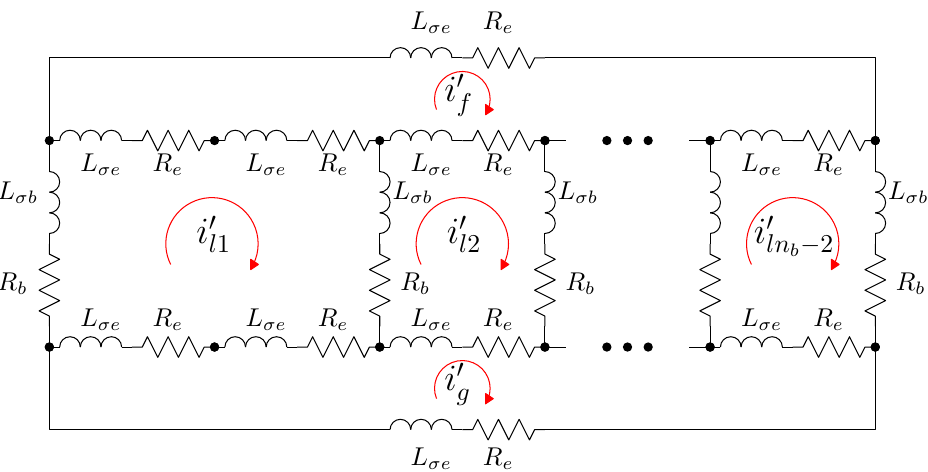
Figure 7. Rotor loops in a squirrel cage rotor of n b bars with a single broken bar ( b 2 ). It is similar to the circuits in a healthy rotor cage shown in Figure 6, but now the first rotor loop is formed by two non-consecutive bars ( b 1 and b 3